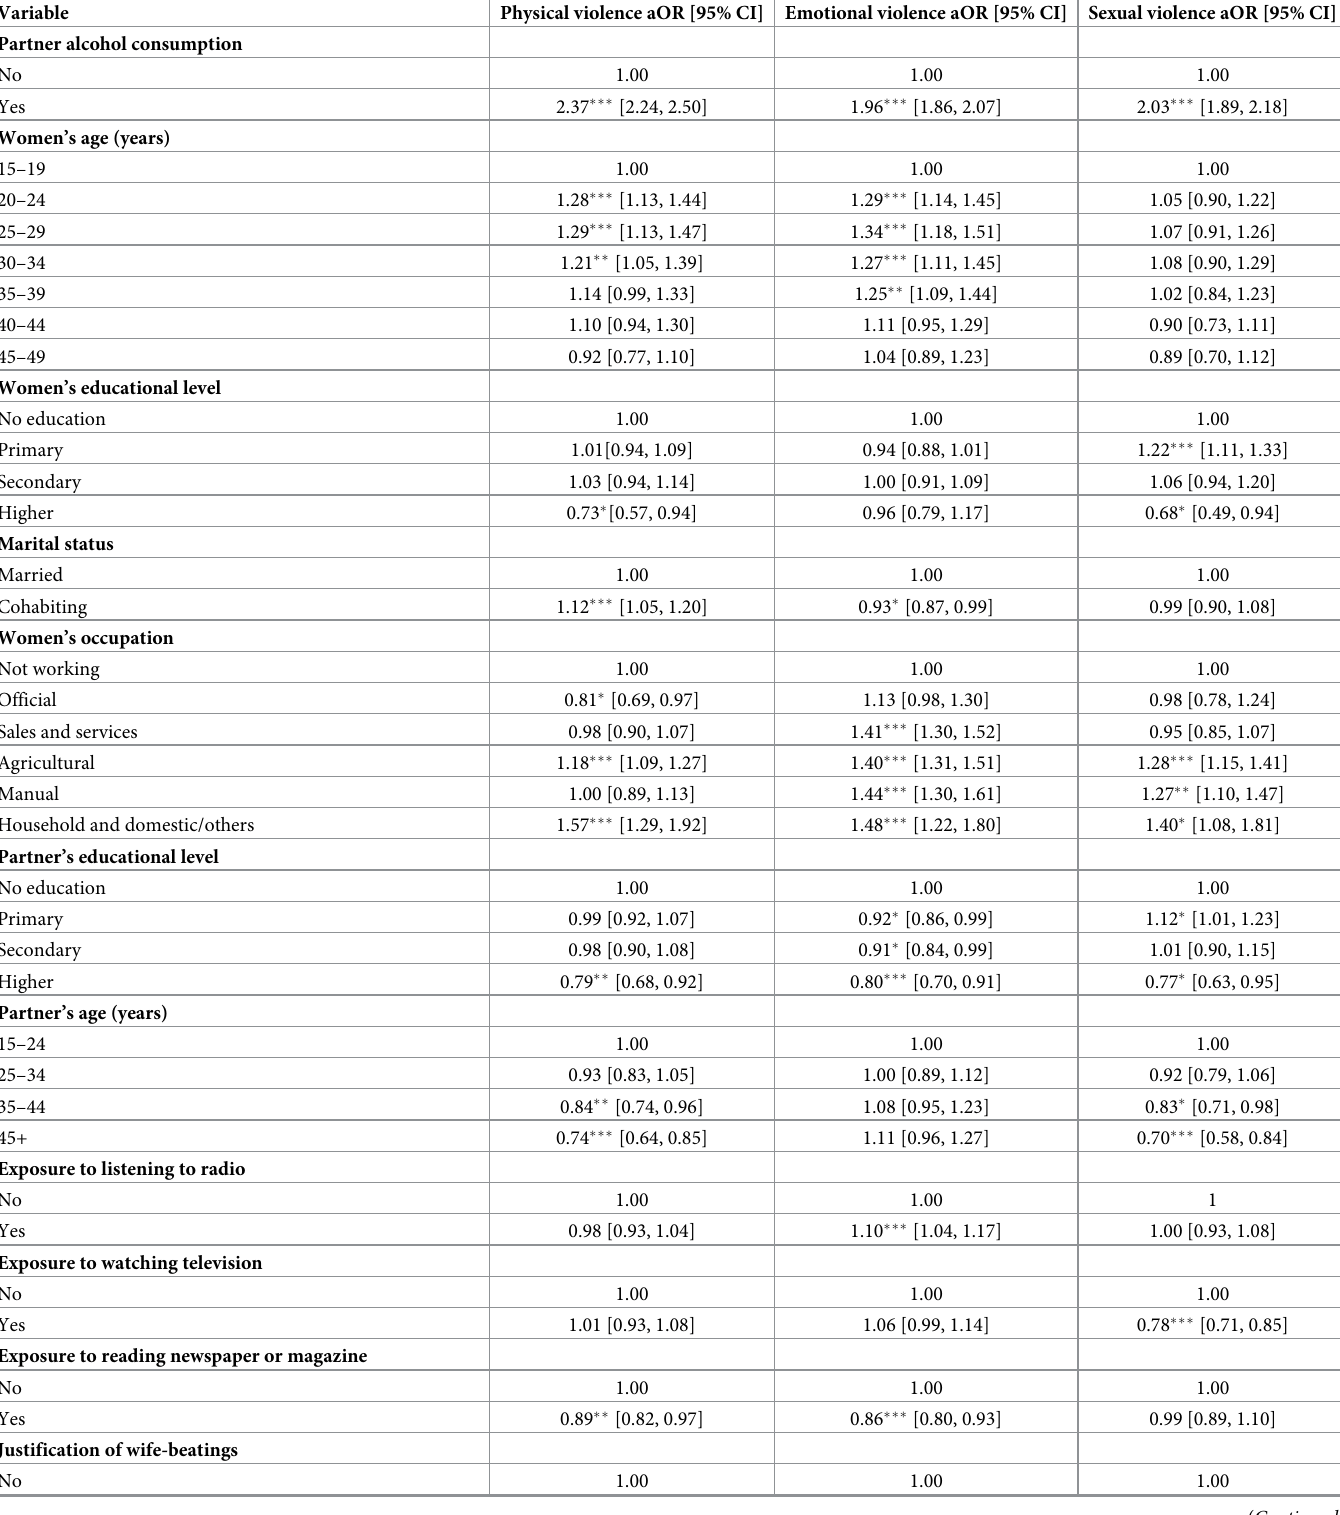
Table 4. Multivariable regression analysis of partner’s alcohol consumption and intimate partner violence among women in sub-Saharan Africa.